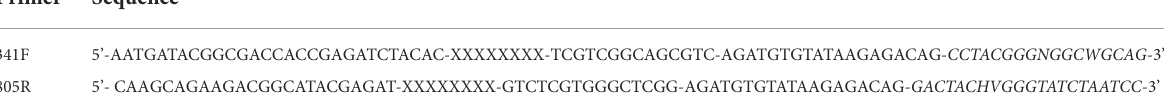
TABLE 1 Primer sequences for PCR targeting the V3–V4 region of bacteria.